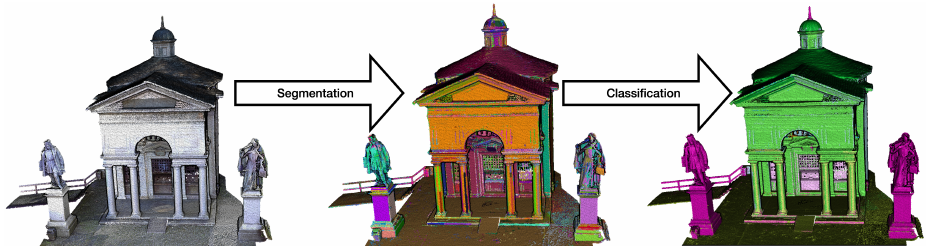
Figure 10. Results of object recognition phases (segmentation and classification) applied to the chapel of the Sacro